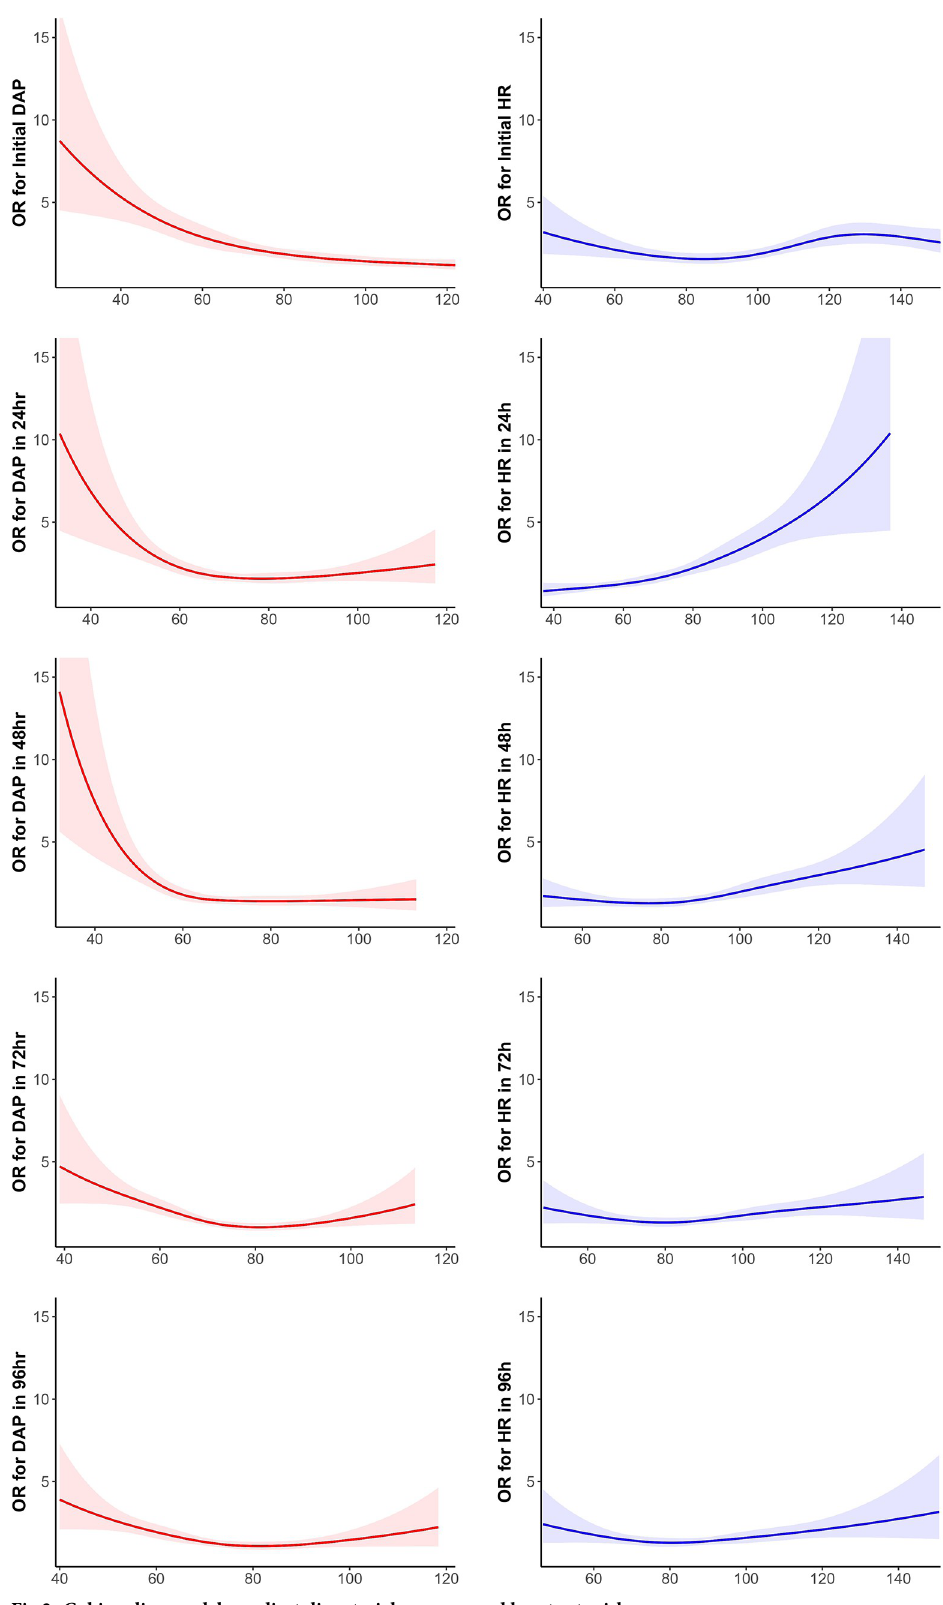
Fig 2. Cubic spline models on diastolic arterial pressure and heart rate risks. https://doi.org/10.1371/journal.pone.0274130.g002 PLOS ONE | https://doi.org/10.1371/journal.pone.0274130 September 14,